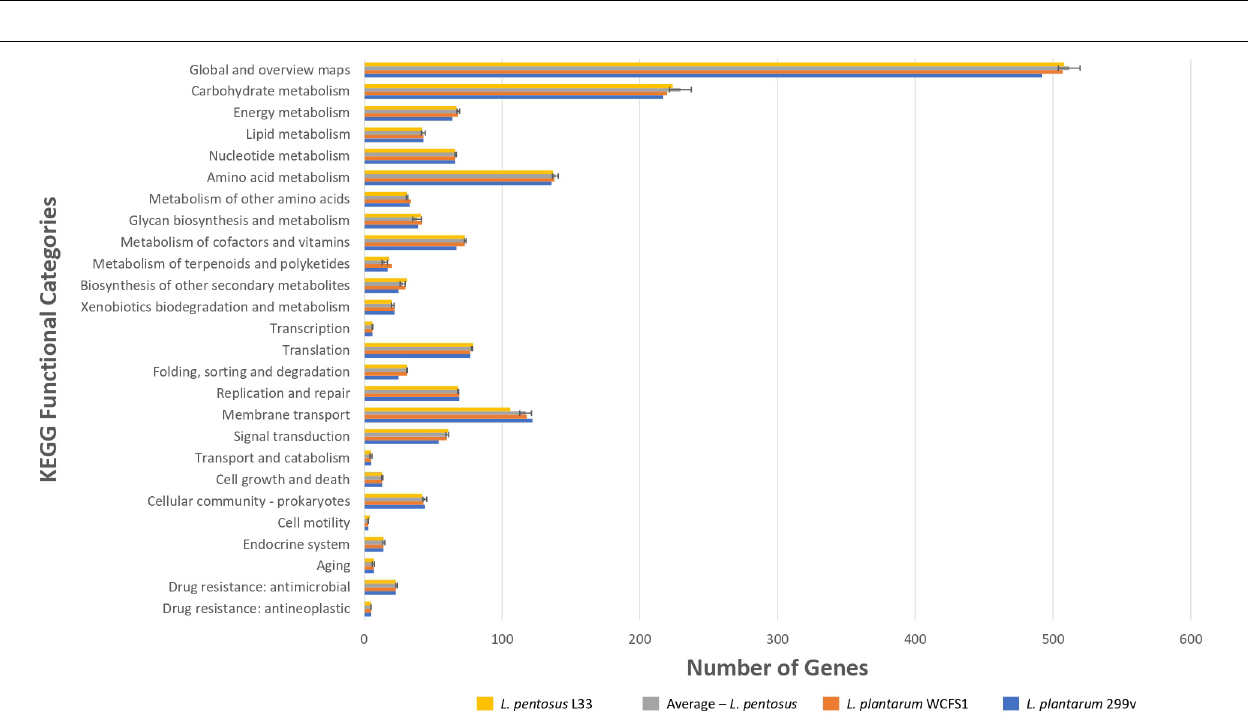
FIGURE 6 | Comparison of the number of genes assigned to the most abundant KEGG functional categories of L. pentosus L33 (Yellow bars), L. plantarum WCFS1 (Orange bars), L. plantarum 299v (Blue bars), and of 26 L. pentosus strains (Gray bars). We calculated the number of genes for each KEGG functional category, for each one of the 26 L. pentosus strains, and depict their average values alongside the standard deviation (Gray bars).